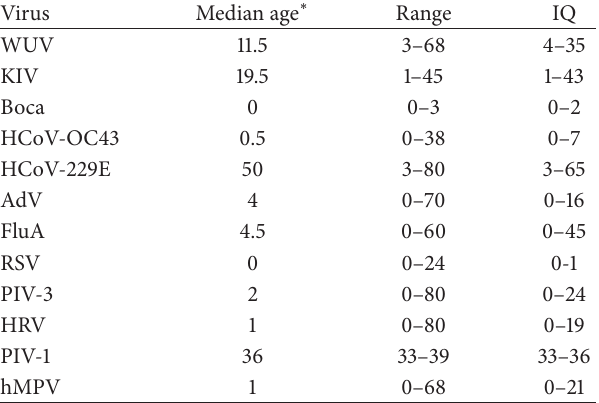
Table 4: Age distribution of respiratory virus found in mixed detection.